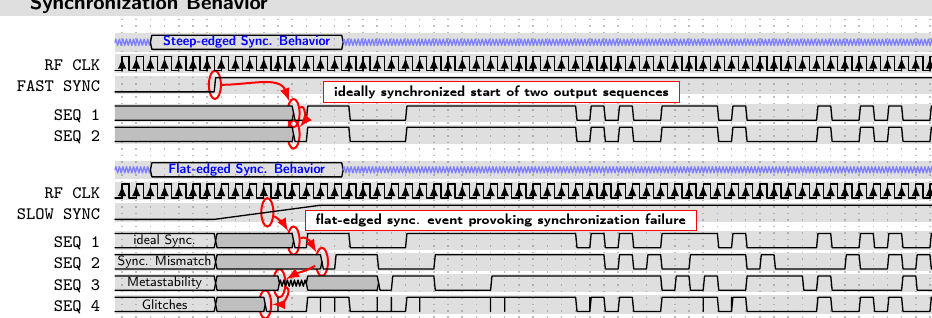
Figure 7. The effect of edge steepness on synchronization behavior within multiple channels. Above: ideal case, i.e., steep synchronization edge at a sufficient distance from the rising clock edge; below: fault-provoking case, i.e., slow synchronization edge covering multiple clock